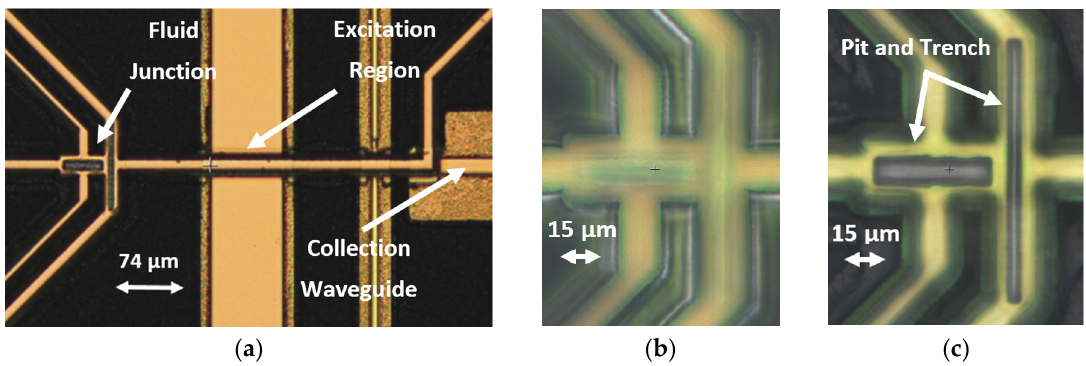
Figure 7. Optical three-dimensional (3D) profilometer images of a completed device center show ( a ) the liquid-core focusing junction and channel and the intersecting solid-core waveguides as well as ( b ) the top of the focusing junction oxide and ( c ) the inside of the focusing junction showing the etch features.